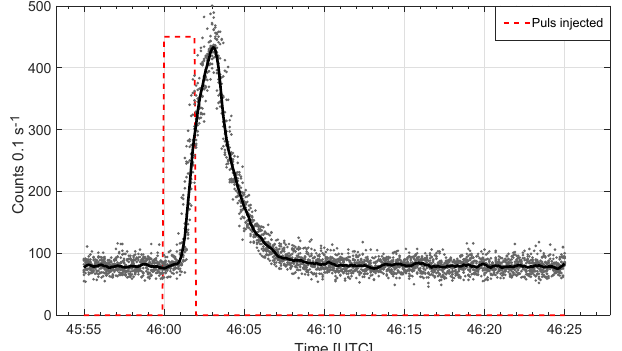
Figure 4. 10 repetitions of the NO pulse (red, dashed) experiment covering 30s time period. The NO pulse (7.1ppb) was injected for 2s directly into the inlet line at each full minute at inlet pressure of 250hPa. The pulse response (black line) is smooth with a running mean (2s). The width (1 /e ) of the peak is 4s, and the delay is about